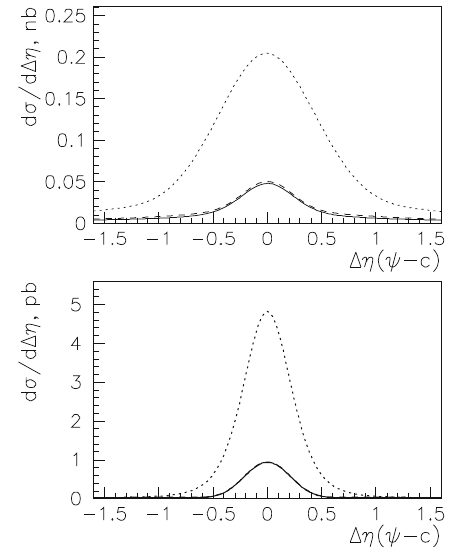
Fig. 6 Pseudorapidity difference between the partners in the J /ψ + c system under the different kinematic selection rules. Upper panel: solid curve, p ψ T > 20 GeV, p ∗ > 5 GeV; dotted curve, p ψ p ∗ T solid curve, p ψ T > 50 GeV, p ∗ > 20 GeV; dotted curve, p ψ GeV, p ∗ T